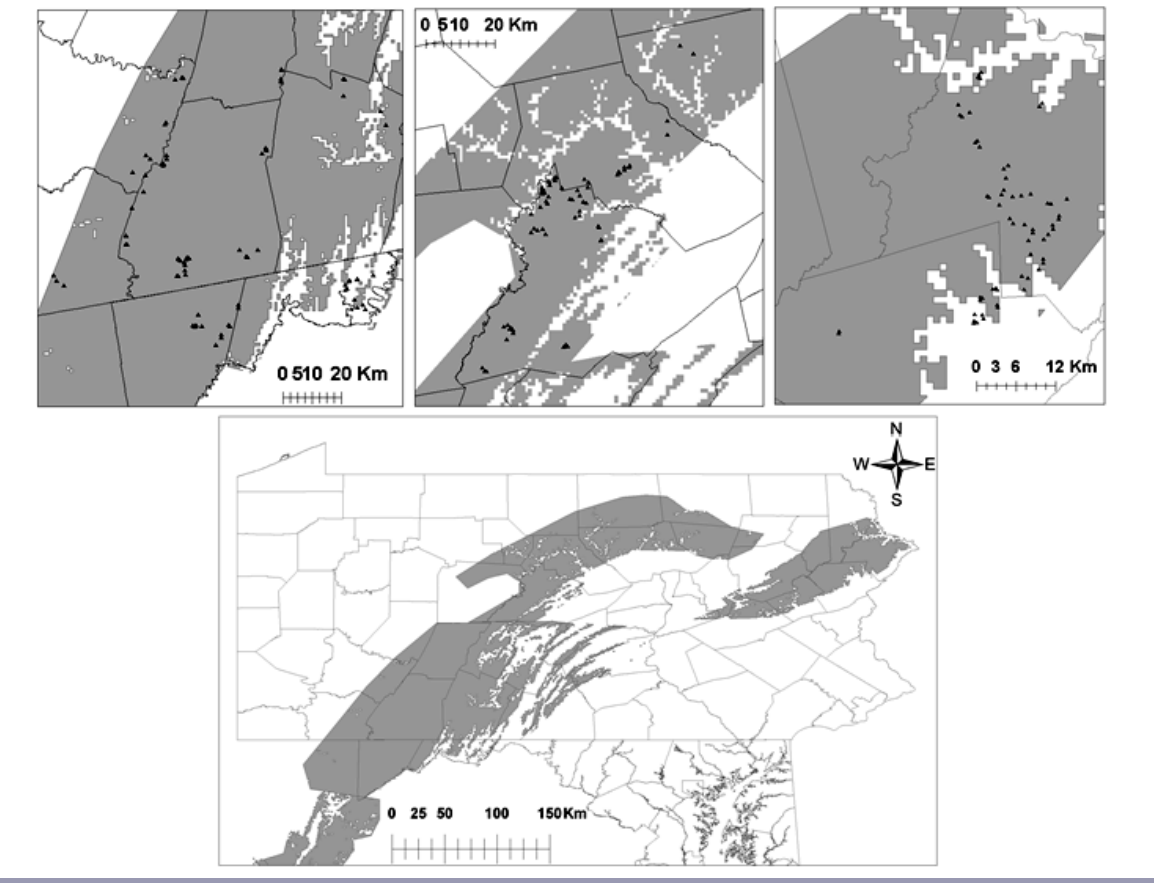
Fig. 1 . Mid-Appalachian ecoregion and the boundary of the conservation focal areas (shaded regions) of Golden-winged Warbler ( Vermivora chrysoptera ) habitat management in Pennsylvania and western Maryland with south-central (top left), north-central (top center), and northeast (top right) study regions. The locations of regenerating stands used in the study are indicated with